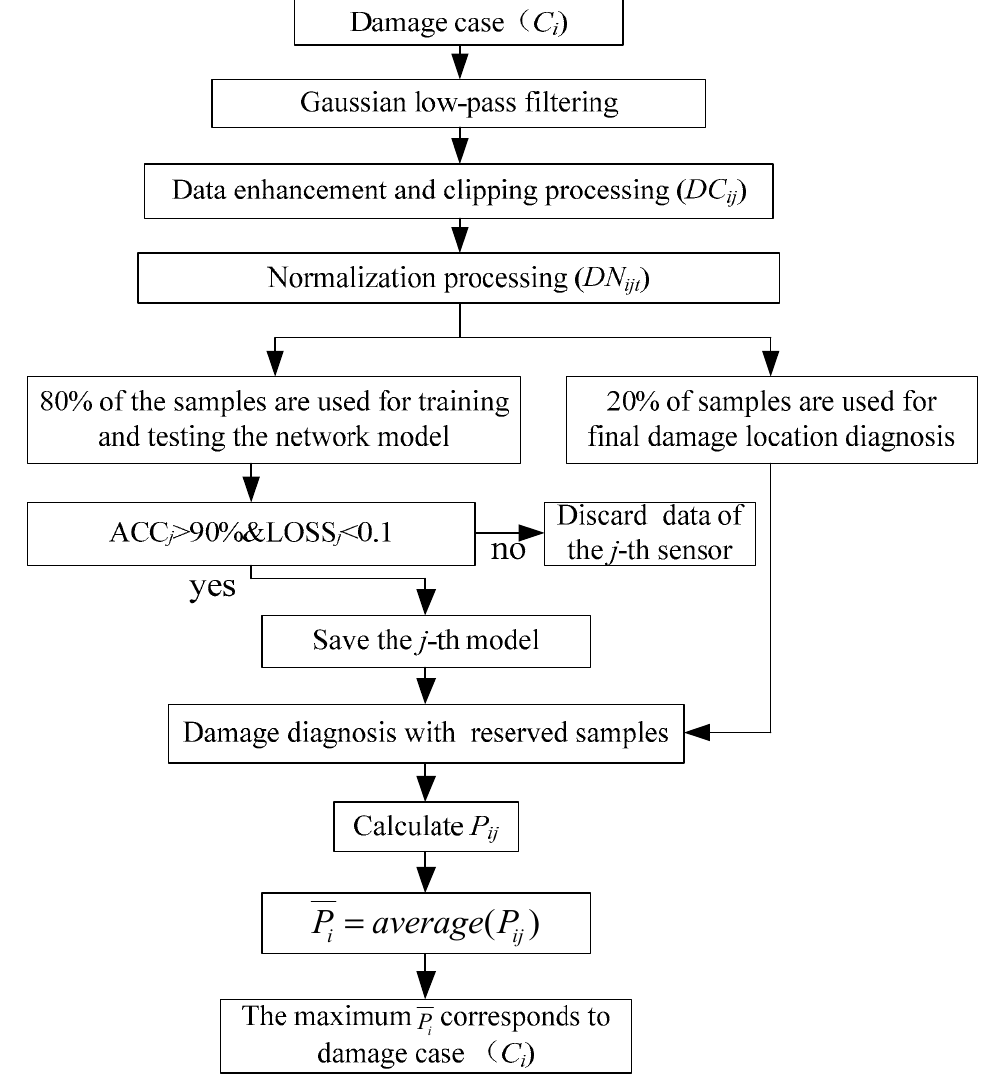
Figure 2. Integrated damage location diagnosis process.